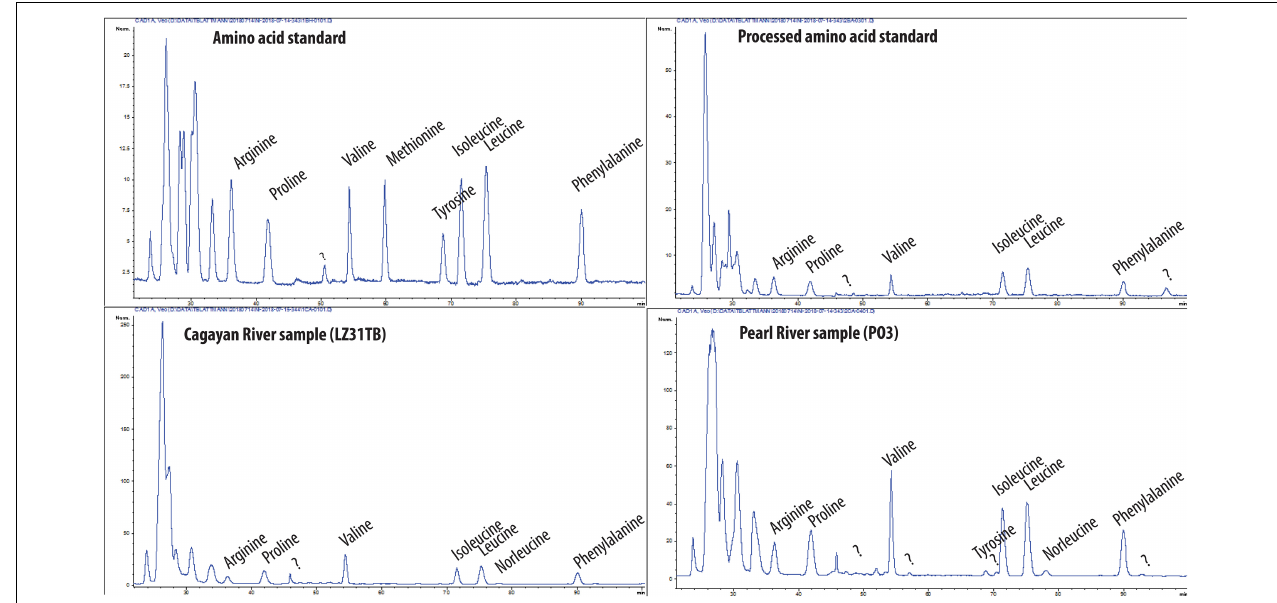
FIGURE 2 | Chromatograms showing CAD traces using the preparative scale CAPCELL C18 column. Top left: unprocessed 18 amino acid standard; top right: 18 amino acid standard which has been subject to the acid hydrolysis and desalting procedure; bottom left: Cagayan River sample LZ31TB; bottom right: Pearl River sample